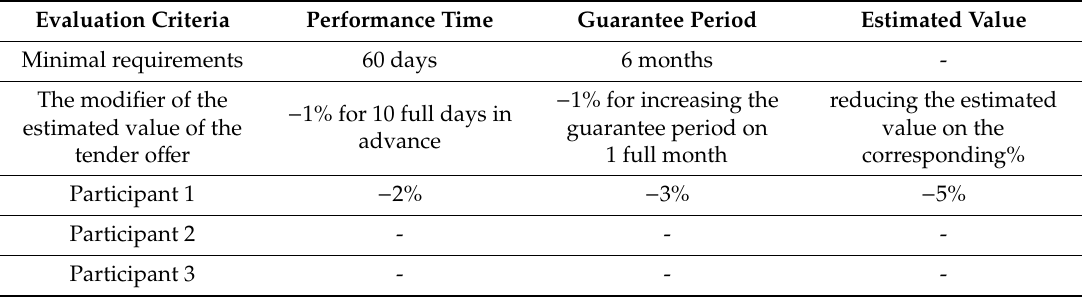
Table 6. Estimated value method.